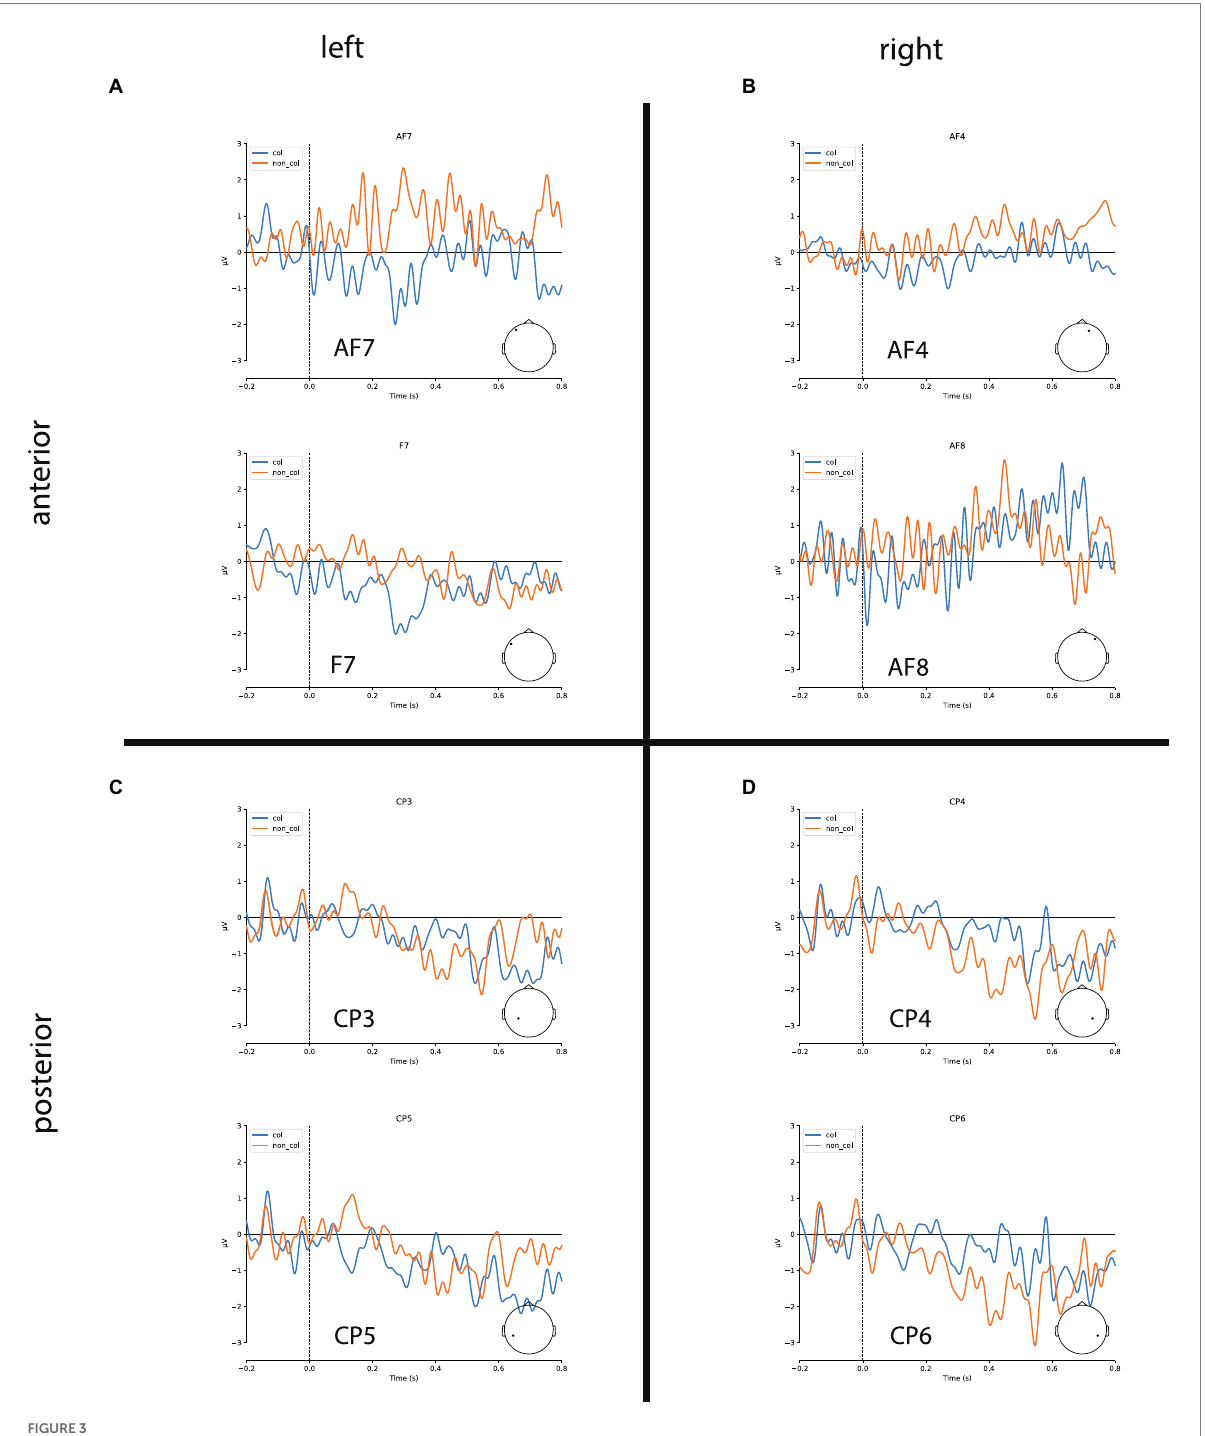
FIGURE 3 Grand averages of ERPs for exemplary channels. (A,B) Collocations (blue) cause larger N400 amplitudes in anterior brain regions compared to non-collocations (orange) in both hemispheres. (C) Collocations induce a clear negativity in the lateral posterior regions of the left hemisphere (Wernicke’s area). (D) Non-collocations cause an increased N400 amplitude in posterior regions of the right